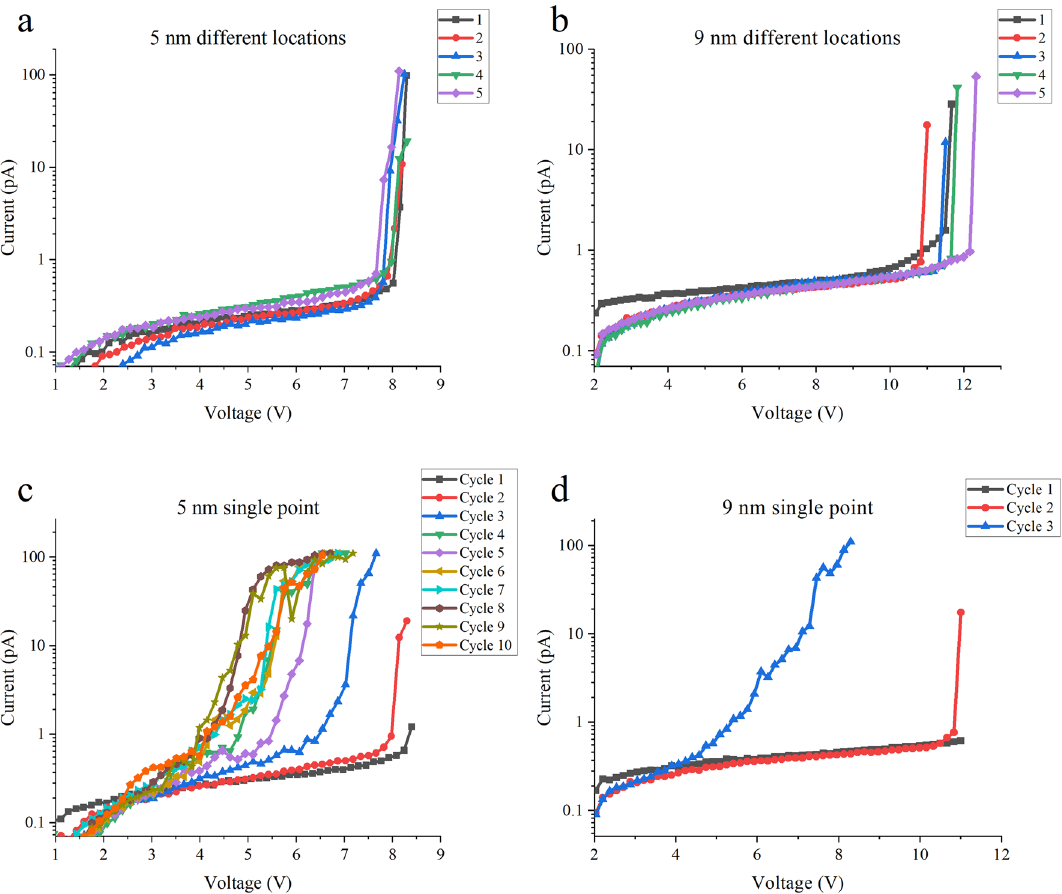
Figure 6. Typical breakdown I-V . BD measured by standard RVS across different points on ( a ) a 5 nm flake and ( b ) a 9 nm flake. There is only a small variation of V BD . Repeated stressing by voltage limited RVS measured at a single location on ( c ) 5 nm and ( d ) 9 nm flakes. Diamond cantilevers are used for all